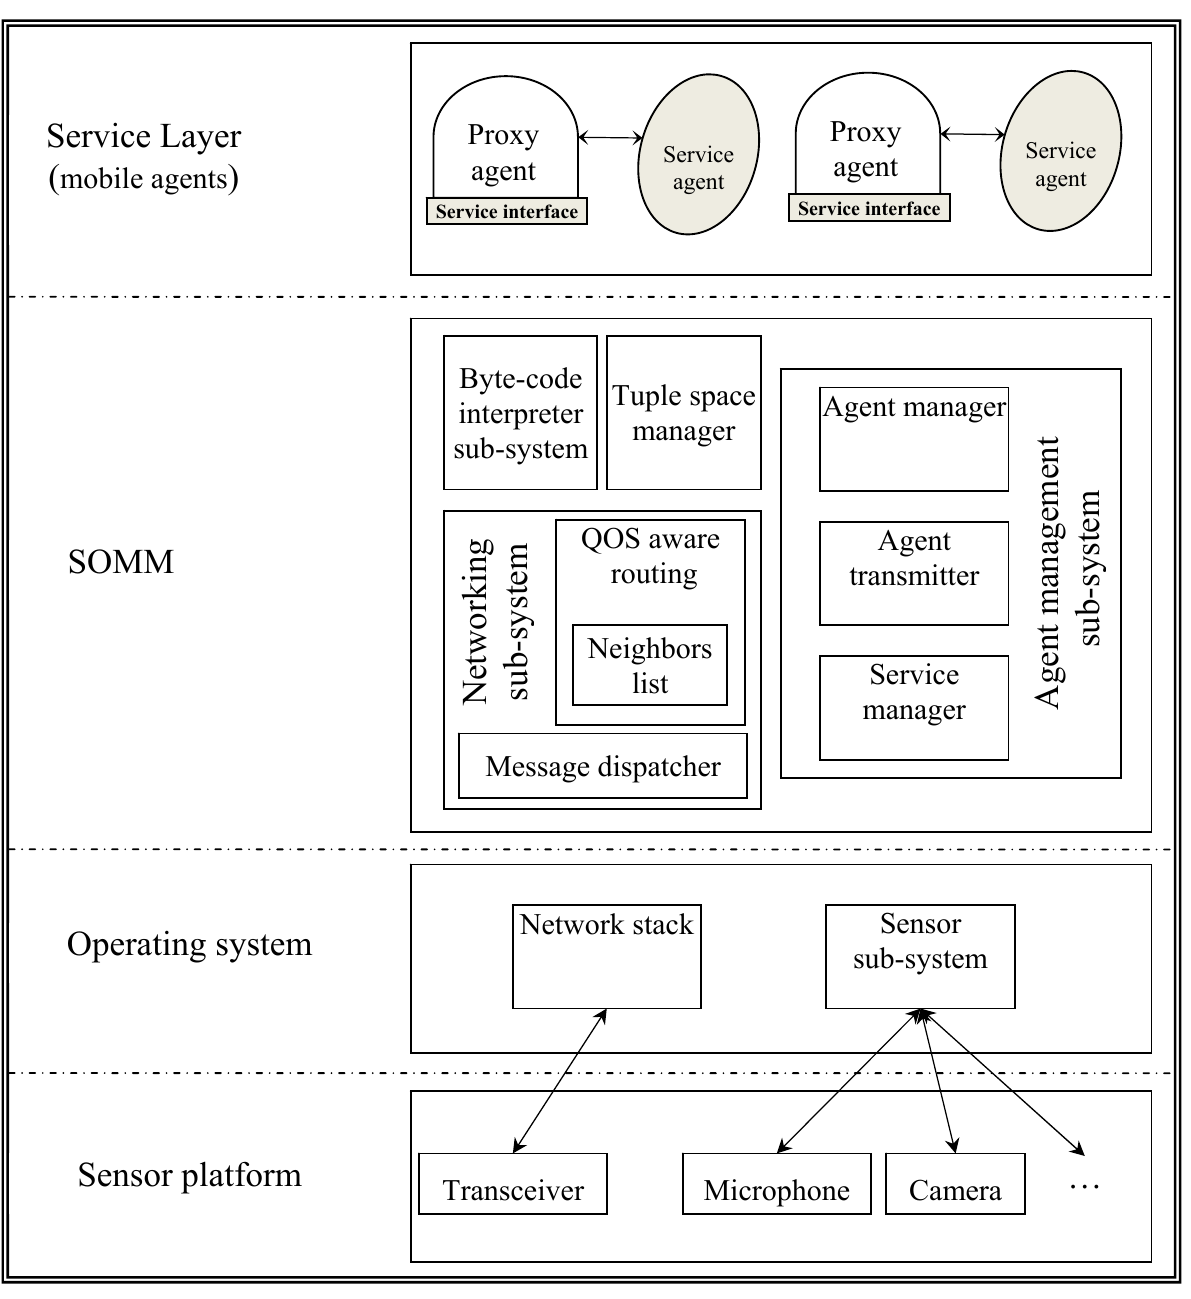
Figure 2. SOMM Architecture in a server